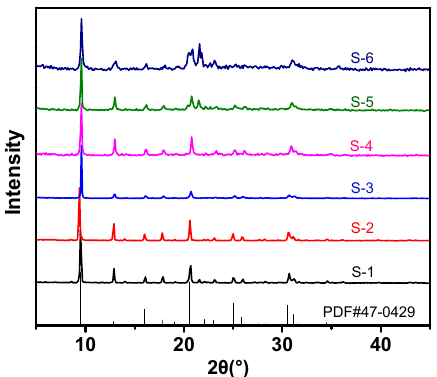
Figure 1. The XRD patterns of the prepared SAPO-34 samples; PDF#47-0429 is the SAPO-34 standard spectrum. Table 1. The structural properties and surface compositions of the catalysts.